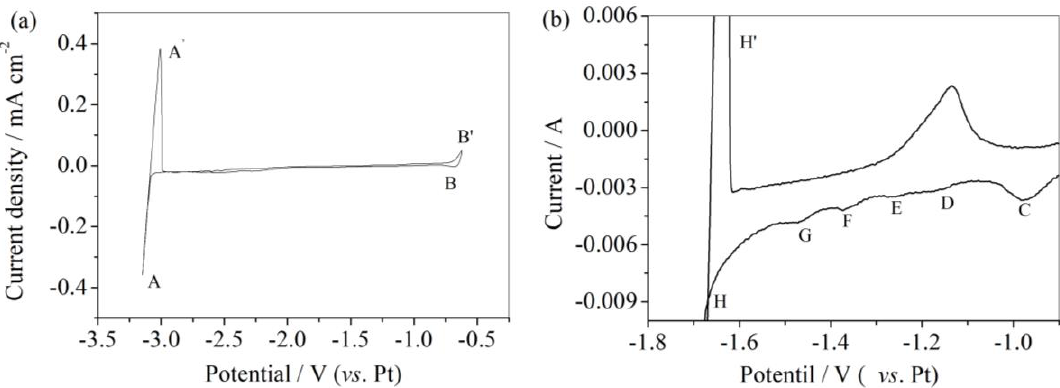
Figure 1. ( a ) Cyclic voltammogram of a Ni wire electrode from LiCl-KCl eutectic melt at 753 K and scan rate = 0.03 V s − 1 . ( b ) Cyclic voltammogram for a Ni sheet electrode in LiCl-KCl-AlCl 3 (2 wt.%) melt at 753 K and scan rate = 0.03 V s − 1 .